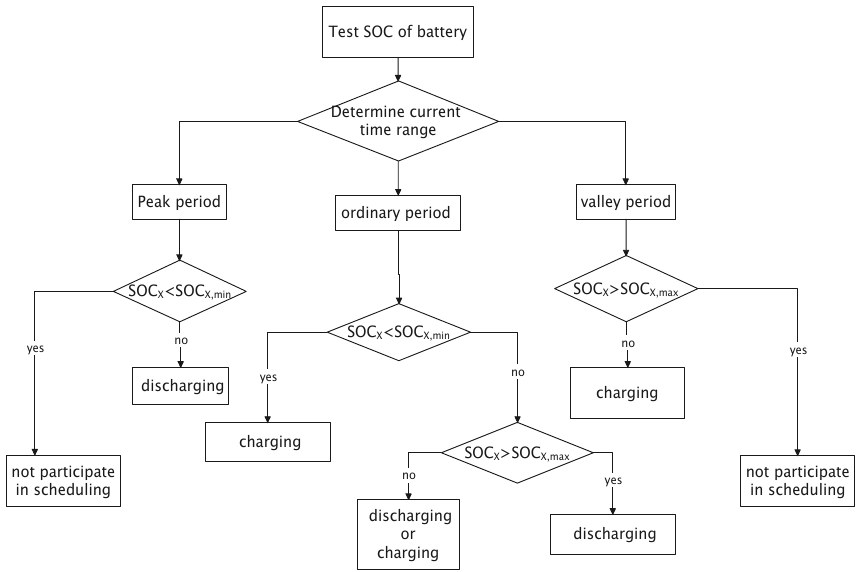
Figure 2. The scheduling strategy of battery